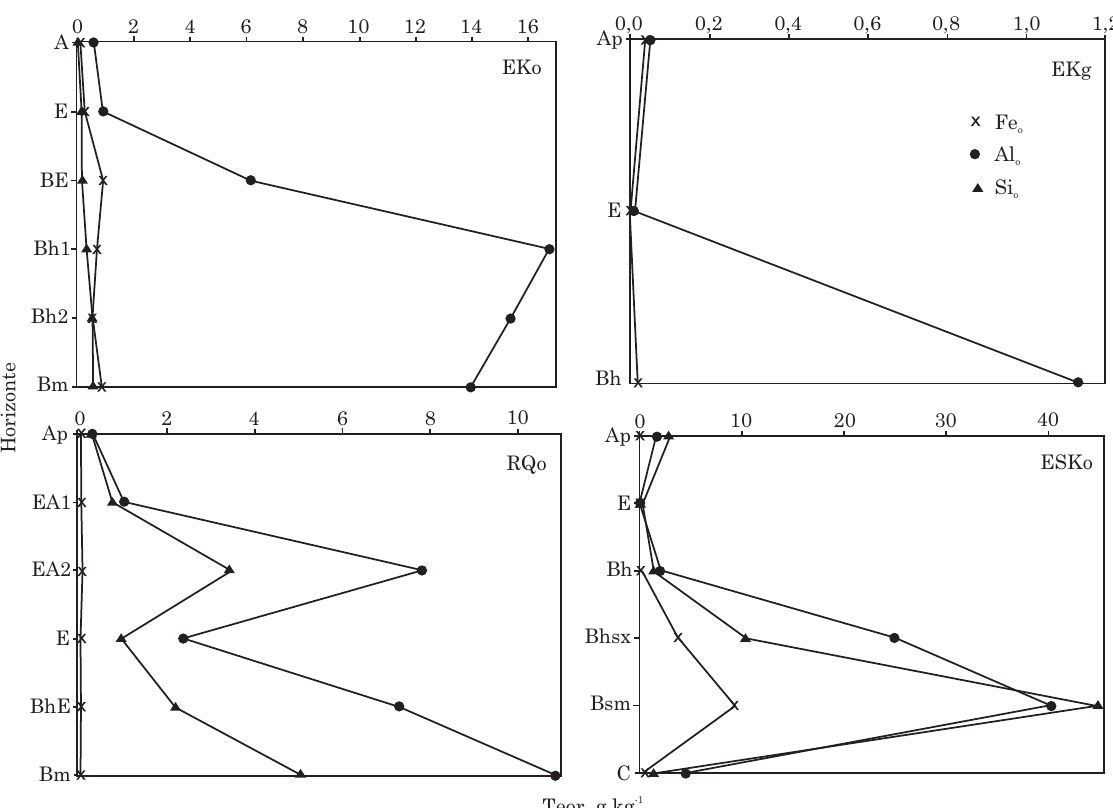
Figura 2. Teores de Fe, Al e Si extraídos pelo oxalato nos horizontes genéticos dos solos